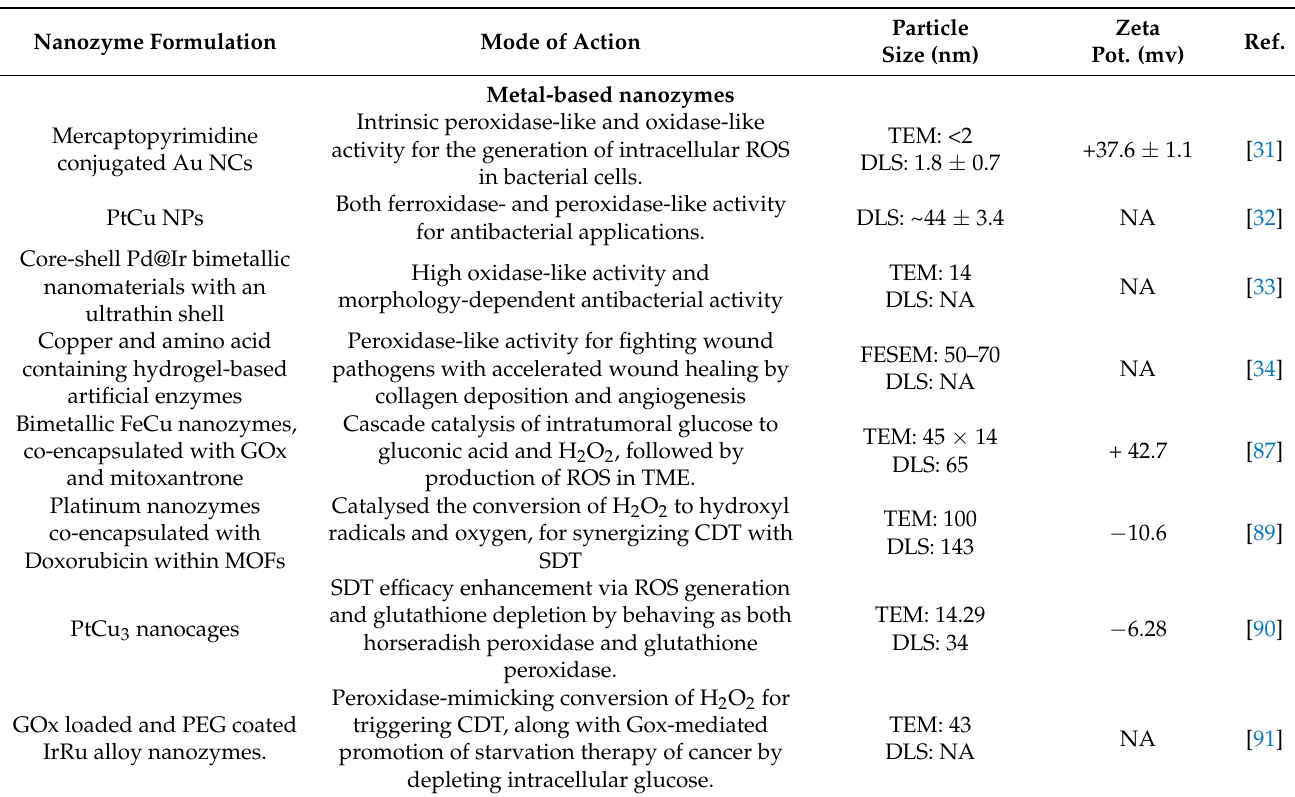
Table 1. A tabular summary of the use of various nanozymes in antibacterial and anticancer applica- tions covered in this review (NA: data not